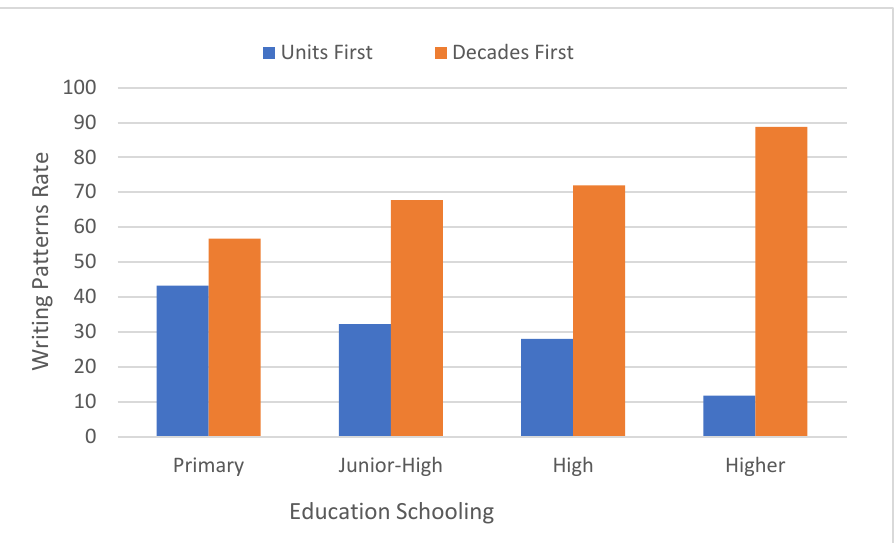
Figure 2. The units-first (right to left) and decades-first (left to right) writing pattern rates as a function of educational level (primary, junior-high, high, higher).